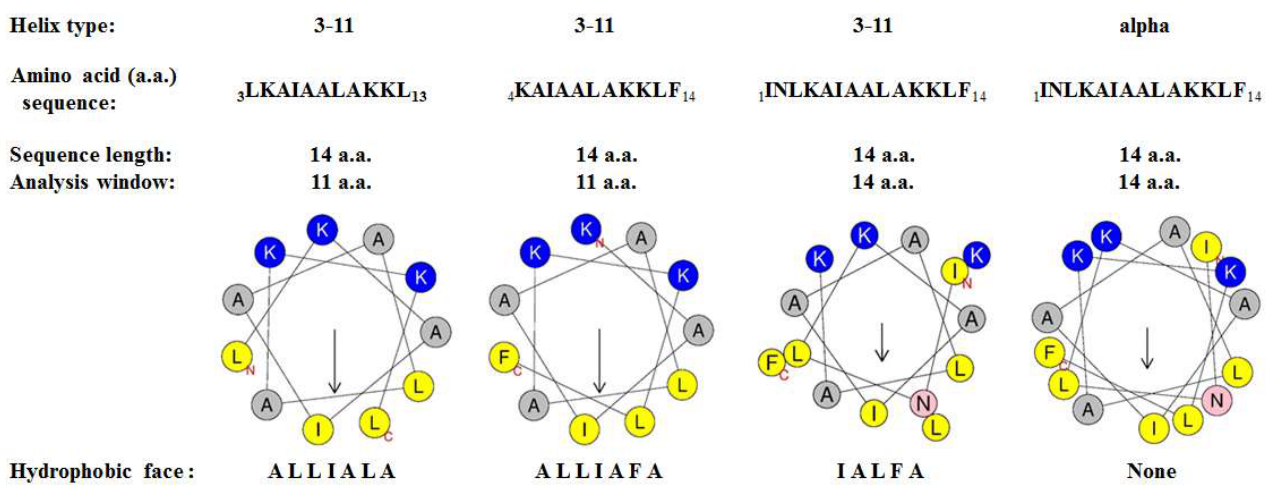
Figure 7. Helical wheel plots of mastoparan-AF. Helical wheel plots were drawn by using the Heliquest software available online [https://heliquest.ipmc.cnrs.fr/], accessed on 4 July, 9 July and 26 July 2021. N denotes the amino terminus and C represents the carboxyl terminus. Amino acid residues are displayed in one letter code. The directions of the hydrophobic moment are indicated by arrows and the magnitudes are proportional to their lengths. Charged, uncharged polar, weak hydrophobic, and strong hydrophobic amino acid residues are shown in blue, pink, grey, and yellow, respectively. Representative 3–11 helical structures with different hydrophobic face versus one α helical structure without hydrophobic face are shown.